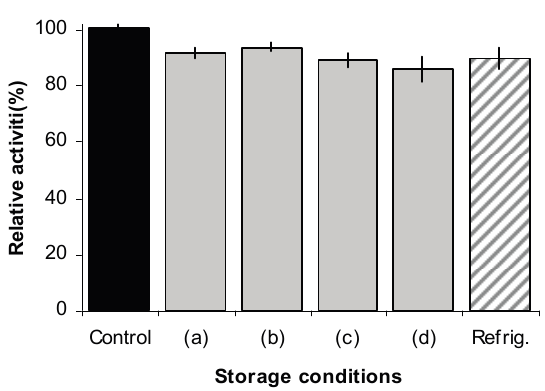
Figure 5. Stability of β -galactosidase immobilized in dry film configuration after 46 days under different storage conditions. Control: freshly prepared enzyme solution. Activity of control solution is used as reference. ( a ) Room temperature (23 ± 2 °C)+ 55% RH; ( b )